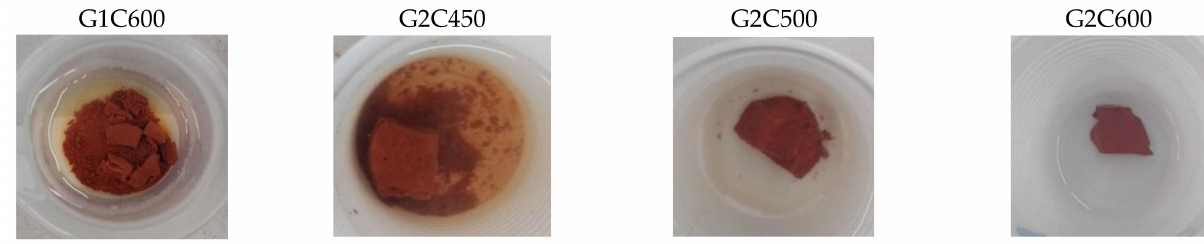
Figure 4. Integrity test in water after 24 h of samples G1C600, G2C450, G2C500, and G2C600.